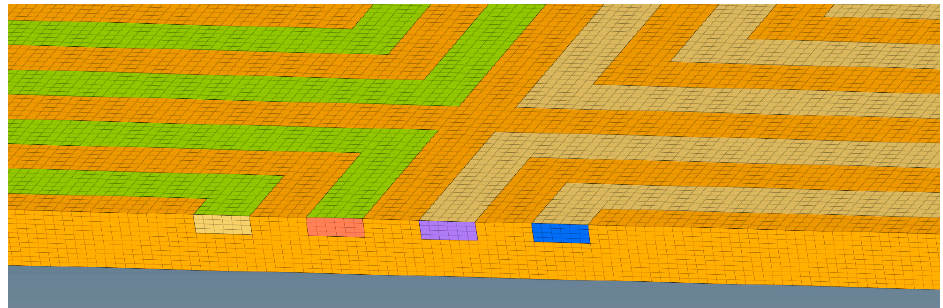
Figure 4. Local mesh of model 3. Table 3. Grid independence verification.